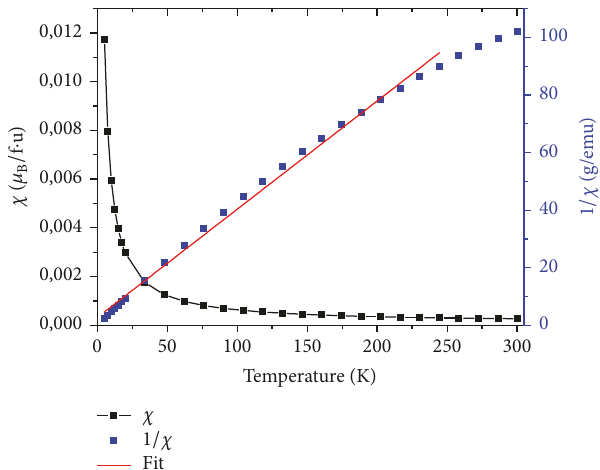
Figure 9: The magnetic susceptibility ( 𝜒 ) and inverse magnetic susceptibility ( 1/𝜒 ) measurements as a function temperature of LiGd 0.96 Eu 0.04 (PO 3 ) 4 .